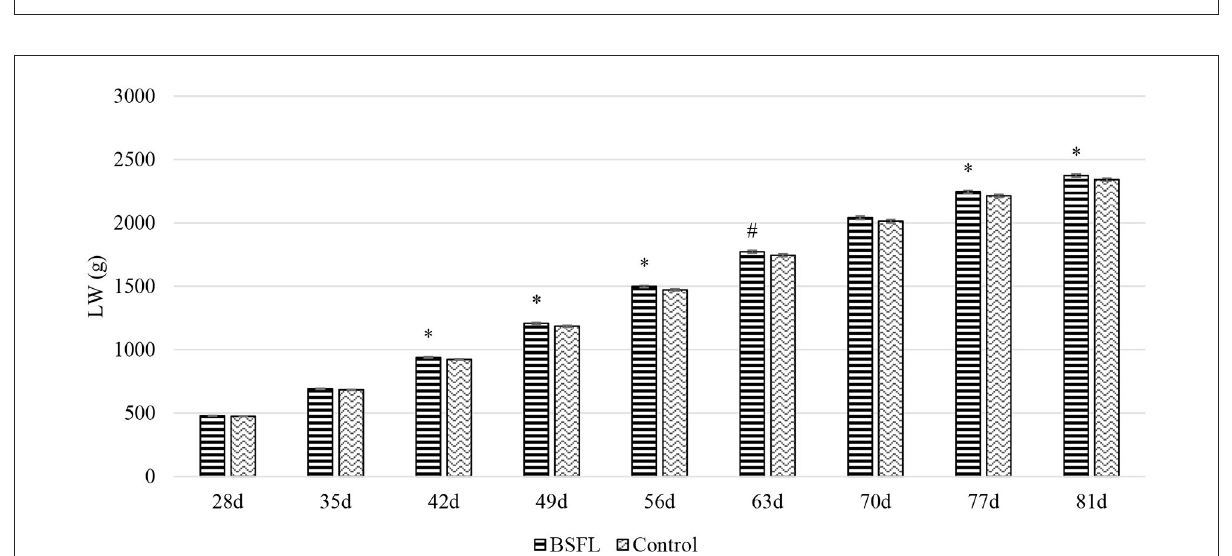
FIGURE2 The growth curves of the Label Rouge Naked Neck birds fed a diet supplemented with 10% live black soldier fly larvae; supplementation based on the expected daily feed intake, (28–81 d; n = 6). # Indicates a statistical trend for the control and BSFL supplemented birds ( P ≤ 0.10); *Indicates a statistical difference between the control and BSFL supplemented birds ( P ≤ 0.05). LW, live